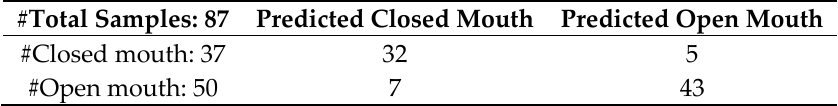
Table 2. Results for the detection of open or closed